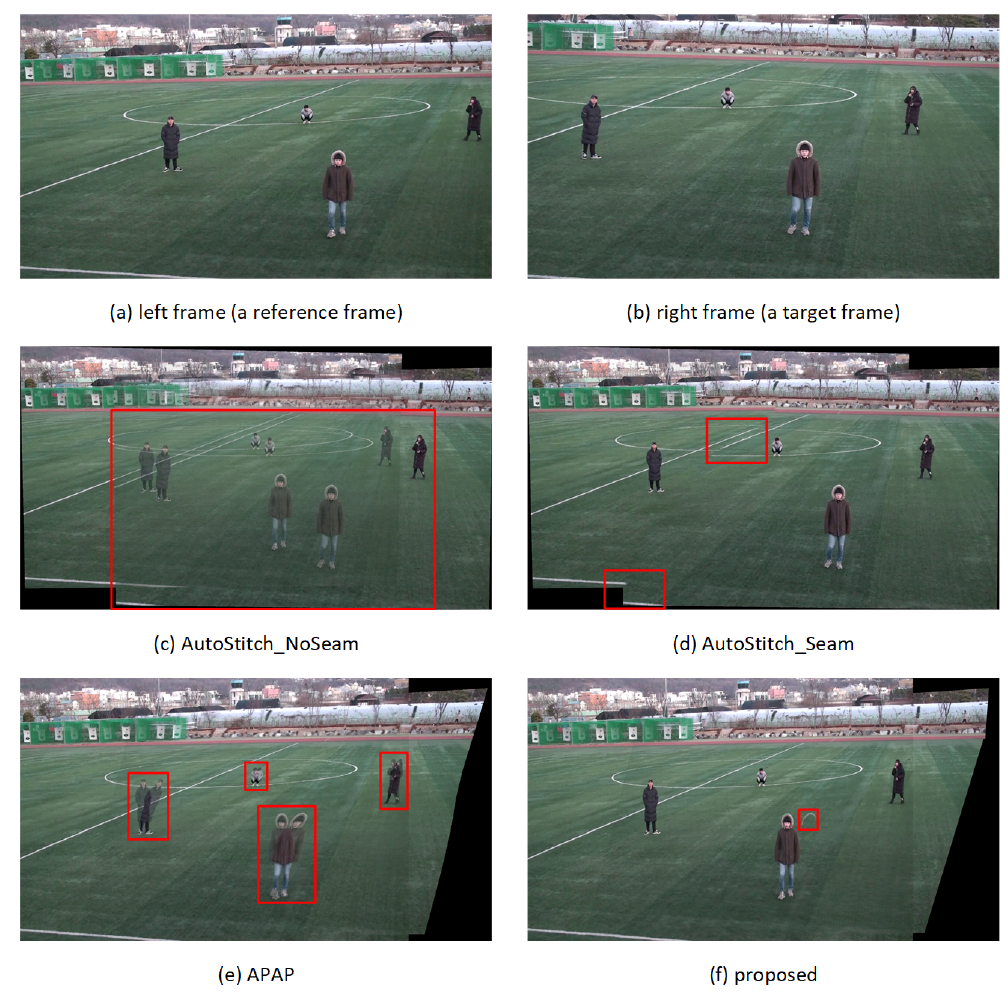
Figure 10. Quality comparison for stitched video frames: seq3